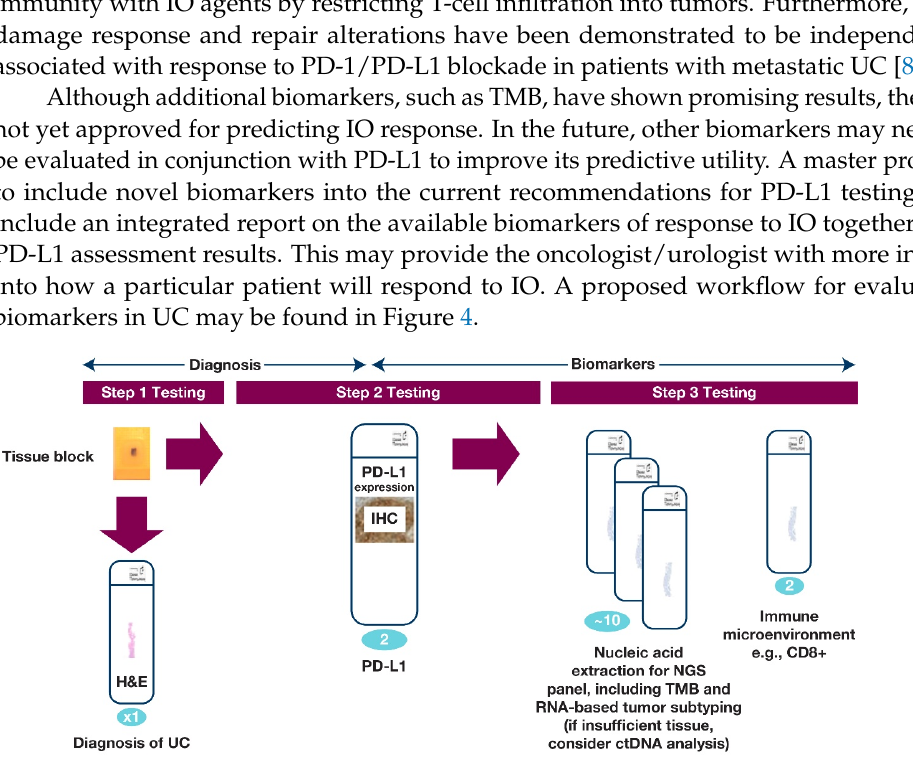
Figure 4. UC biomarkers workflow, which is an integrated platform to report PD-L1 and other biomarkers. Figure 4 illustrates a prospective integrated protocol for multiple biomarker testings on samples from patients with UC. The numbers of sections required are shown in blue. Ideally, in the future, step 1 testing would be combined with step 2 testing to accelerate information to the clinician and inform potential treatment. A minimum of two slides are required for PD-L1 testing and tissue requirements for next-generation sequencing (NGS) may vary according to the testing platform